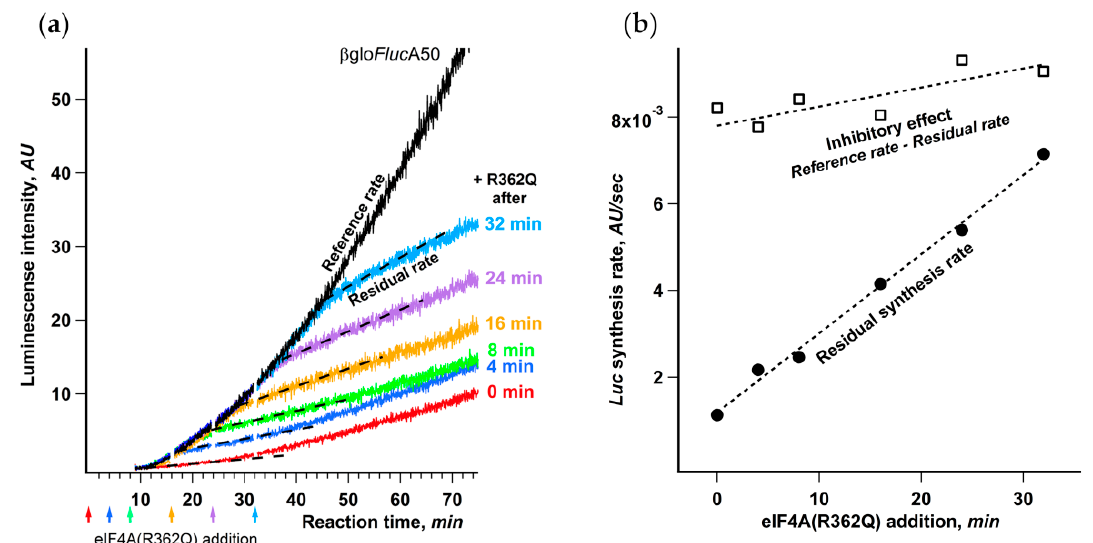
Figure 7. Dependence of the initiation on eIF4A decreases in the course of translation. ( a ) eIF4A(R362Q) was added to final concentration of 40 μ g/mL to the same reaction mixtures of Krebs-2 system translating β gloFlucA50 mRNA at the time points indicated by arrows. The dashed lines represent the residual synthesis rate as the slope of the linear fit of the data collected during the 5 min after the occurrence of eIF4A(R362Q) inhibitory e ff ect; ( b ) dependence on the time eIF4A(R362Q) addition of the residual synthesis rate ( ● ) and the inhibitory e ff ect ( □ ) as the di ff erence between the residual synthesis rate and a reference synthesis rate, where the latter is a slope of the kinetic curve of uninhibited reaction determined at the same time range as the corresponding residual synthesis rate.